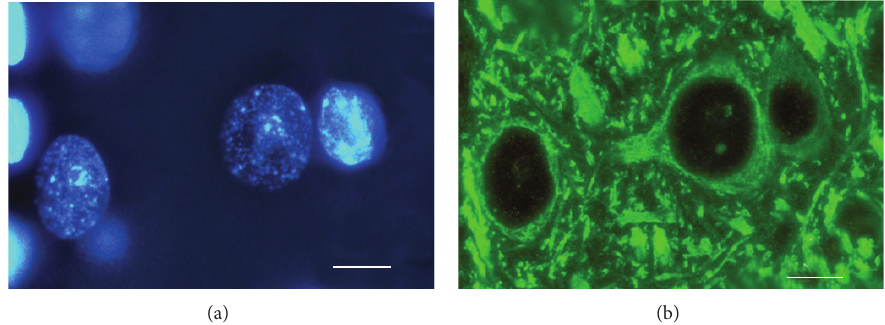
Figure 11: MAP2 expression in a heterokaryon. (a) Neuronal nucleus (larger and darker) and an adjacent reprogramming oligodendrocytic nucleus (smaller in size and brighter). (b) The same section area under a green filter. The circle of green matter (MAP2 immunoreactivity) surrounds the nuclei of both the neuron and the oligodendrocyte. (a) DAPI staining. (b) Immunocytochemical detection of MAP2 labeled by DyLight 488. The scale bar is 10 𝜇